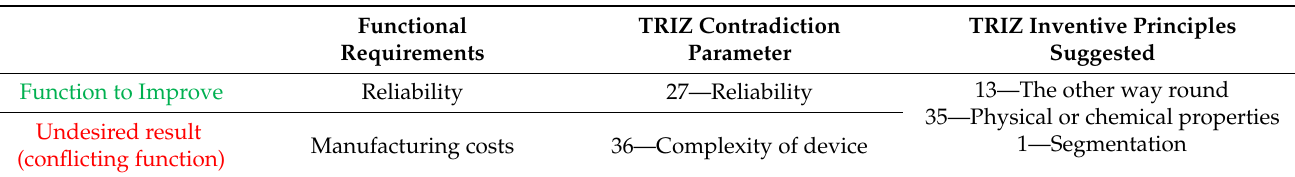
Table 7. Example of suggested inventive principles for the conflicting requirements in the tidal energy array improvement case, showing both the function to be improved (highlighted in green) and the undesired conflicting result(highlighted in red) for the highest conflicting functional requirements, plus the TRIZ inventive principles that may help resolve this.